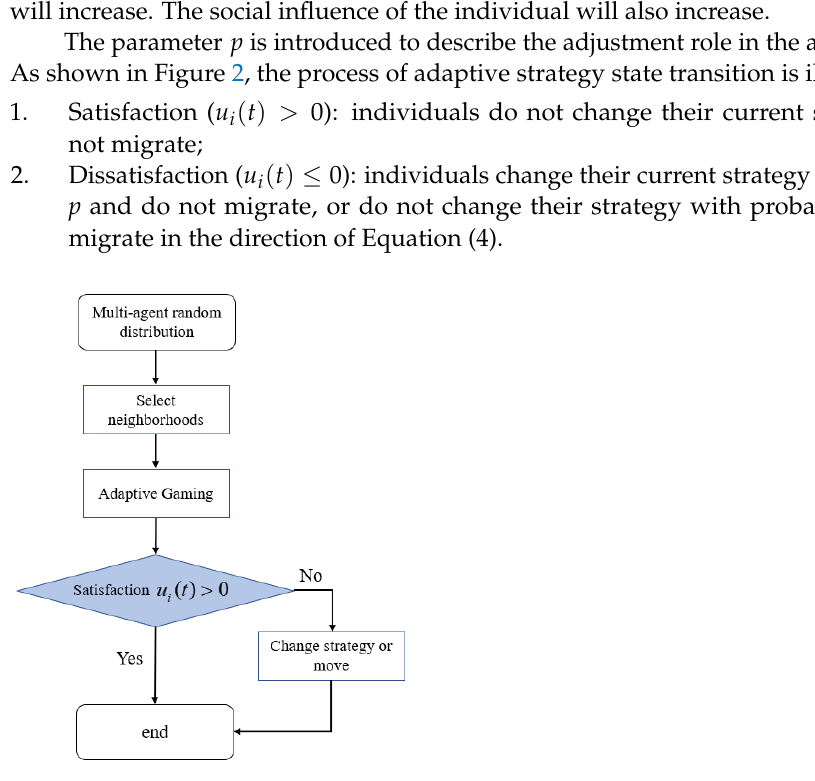
Figure 2. Process flow diagram of adaptive strategy state transition.